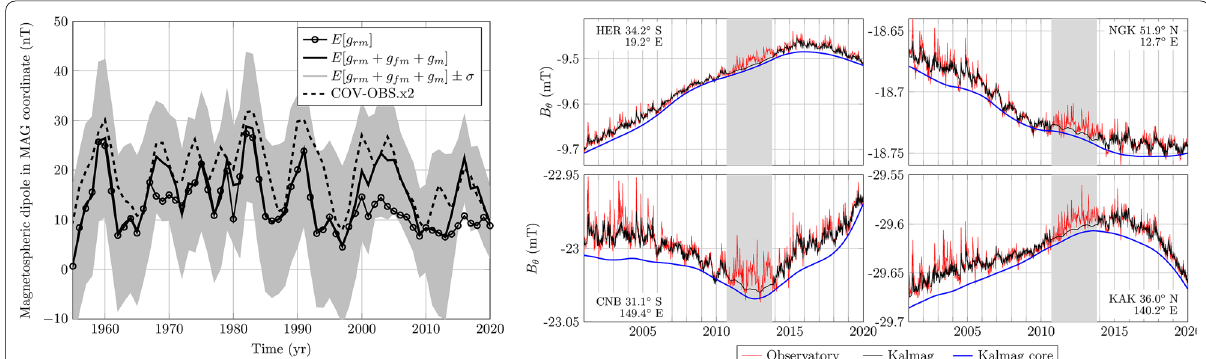
Fig. 10 Left: annual average of the mean dipole component in magnetic coordinates associated with the remote magnetospheric field g rm (line with circles), the sum of the remote g rm , close g m , and fluctuating g fm magnetospheric fields (black line), and the COV‑OBS.x2 model by Huder et al. (2020) (dashed line). The gray area represents the confidence interval predicted by E [ g rm + g m + g fm ] ± σ . Right: azimuthal component of the geomagnetic field taken during night‑time and averaged over 10 days time periods at the level of four ground observatories, Niemegk (top left), Kakioka (top right), Hermanus (bottom left), and Canberra (bottom right). Red lines correspond to observatory data, black lines to the full Kalmag model predictions and blue lines to the Kalmag core field